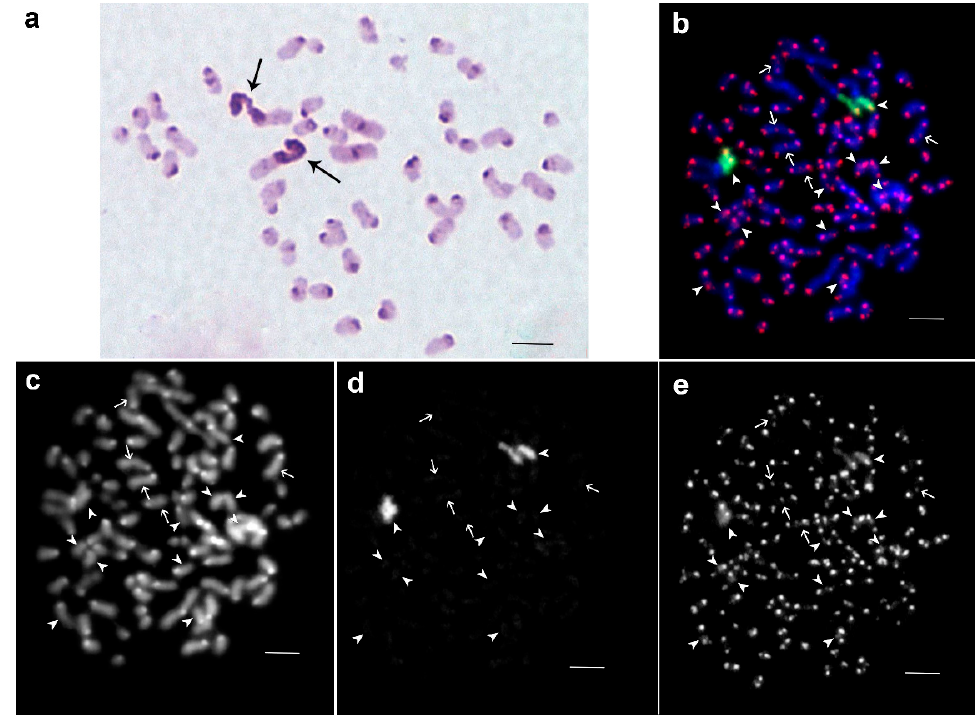
Figure 3. Metaphase plates of female embryo of S. inexpectata . ( a ) C-banding: large metacentrics contain C-positive arms (arrows); ( b ) FISH as in Figure 1b; shown are late metaphase chromosomes (chromatids of many chromosomes were separated); ( c ) DAPI staining; ( d ) FISH with 18S rDNA only; ( e ) FISH with labeled telomeric repeats only. The arrowheads show the regions containing the dispersed telomeric repeats. The arrows show interstitial telomeric sites. Scale bar indicates 5 μ m.